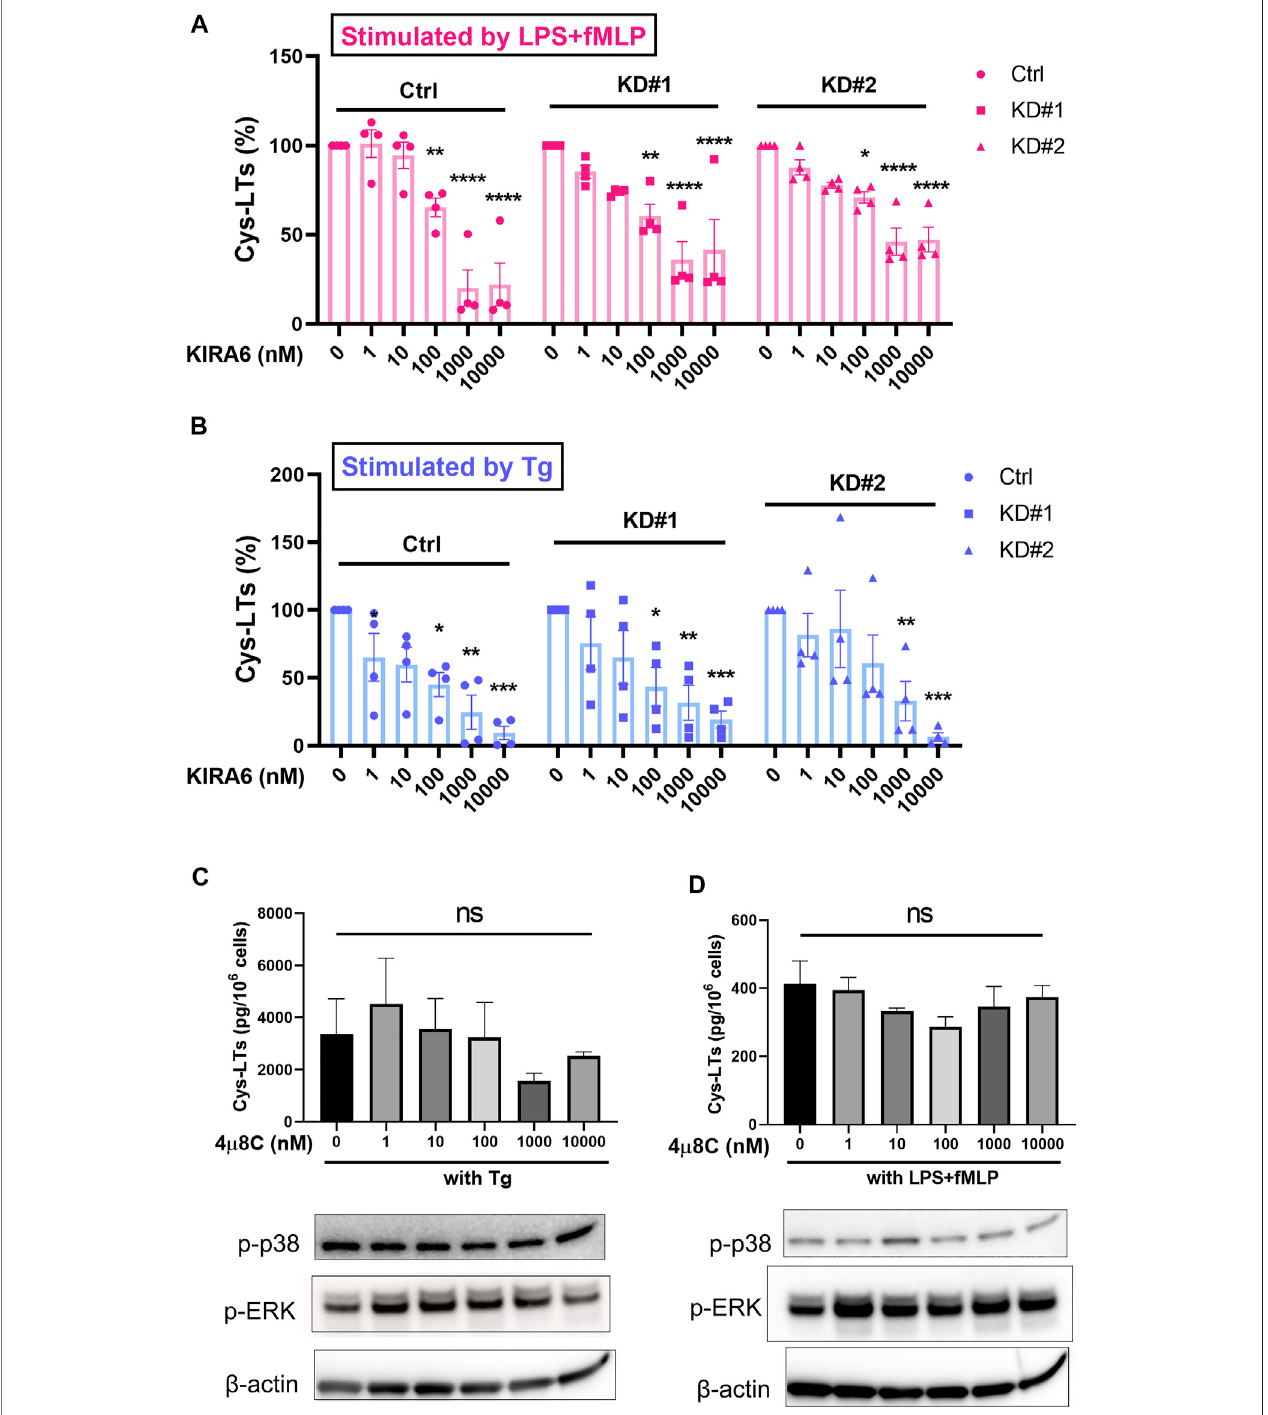
FIGURE 3 | KIRA6 inhibits leukotriene biosynthesis by a mechanism independent of IRE1 α . (A,B) MM6 cells transfected with shRNA against non-target shRNA (Control)andIRE1 α (KD#1andKD#2)weretreatedwithdifferentconcentrationsofKIRA6,followedbychallengewithLPS(100ng/ml,10 min)andfMLP(5 μ M,30 min), or Tg alone (1 μ M, 30 min). Cys-LTs production in cell supernatants were analyzed by ELISA ( n = 4). (C,D) MM6 cells were pretreated with vehicle (0.1% DMSO) or different concentrations of 4 µ8C for 30 min, followed by challenge with LPS (100 ng/ml, 10 min) and fMLP (5 μ M, 30 min), or Tg alone (1 μ M, 30 min). Phosphorylated p38 (p-p38) and p-ERK were analyzed by western blot (representative of three independent experiments). Cys-LT production in cell supernatants were analyzed by ELISA ( n = 4). *p < 0.05, **p < 0.01, ***p < 0.001, ****p < 0.0001, ns: no signi fi cance.